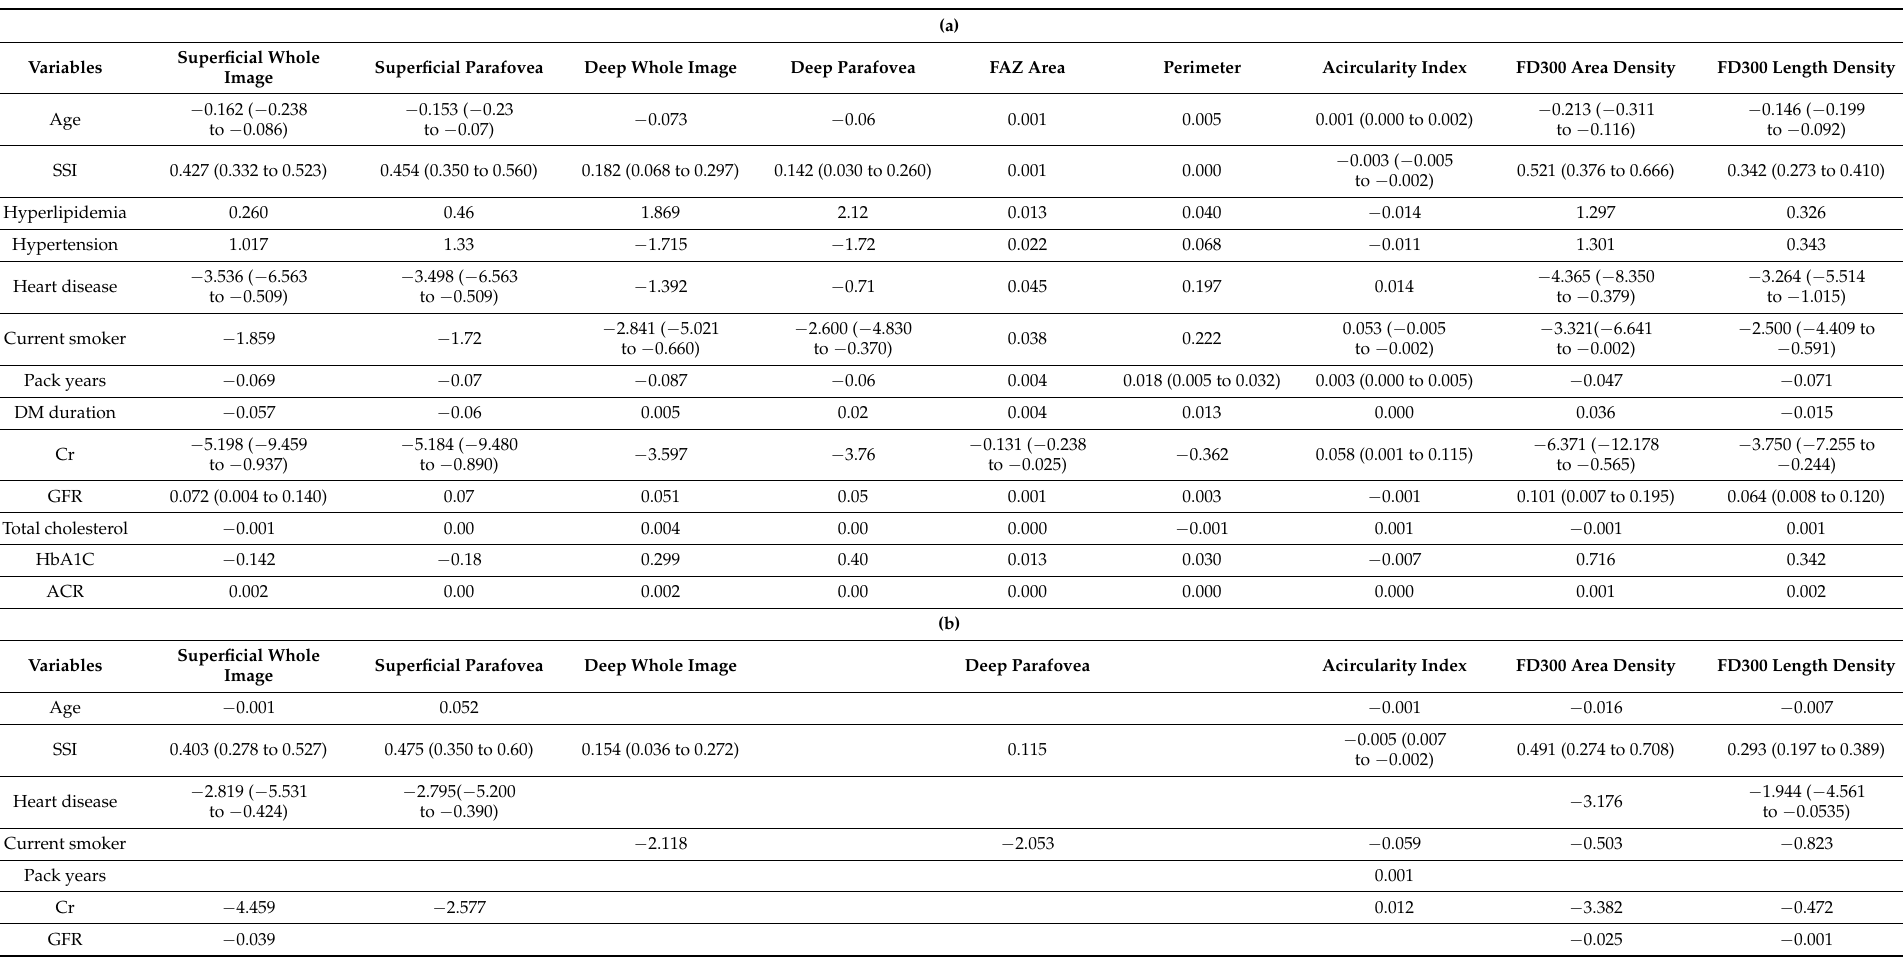
Table 3. ( a ) Results of Univariate Analysis. Correlation coefficients are provided for all parameters and variables. Values that are bolded are statistically significant ( p < 0.05) and the 95% confidence interval is provided. ( b ) Results of Multivariate Analysis. Correlation coefficients are provided for all parameters and variables. Values that are bolded are statistically significant ( p < 0.05) and the 95% confidence interval is provided. Variables and parameters that did not have multiple statistically significant variables in the univariate analysis were not included in this